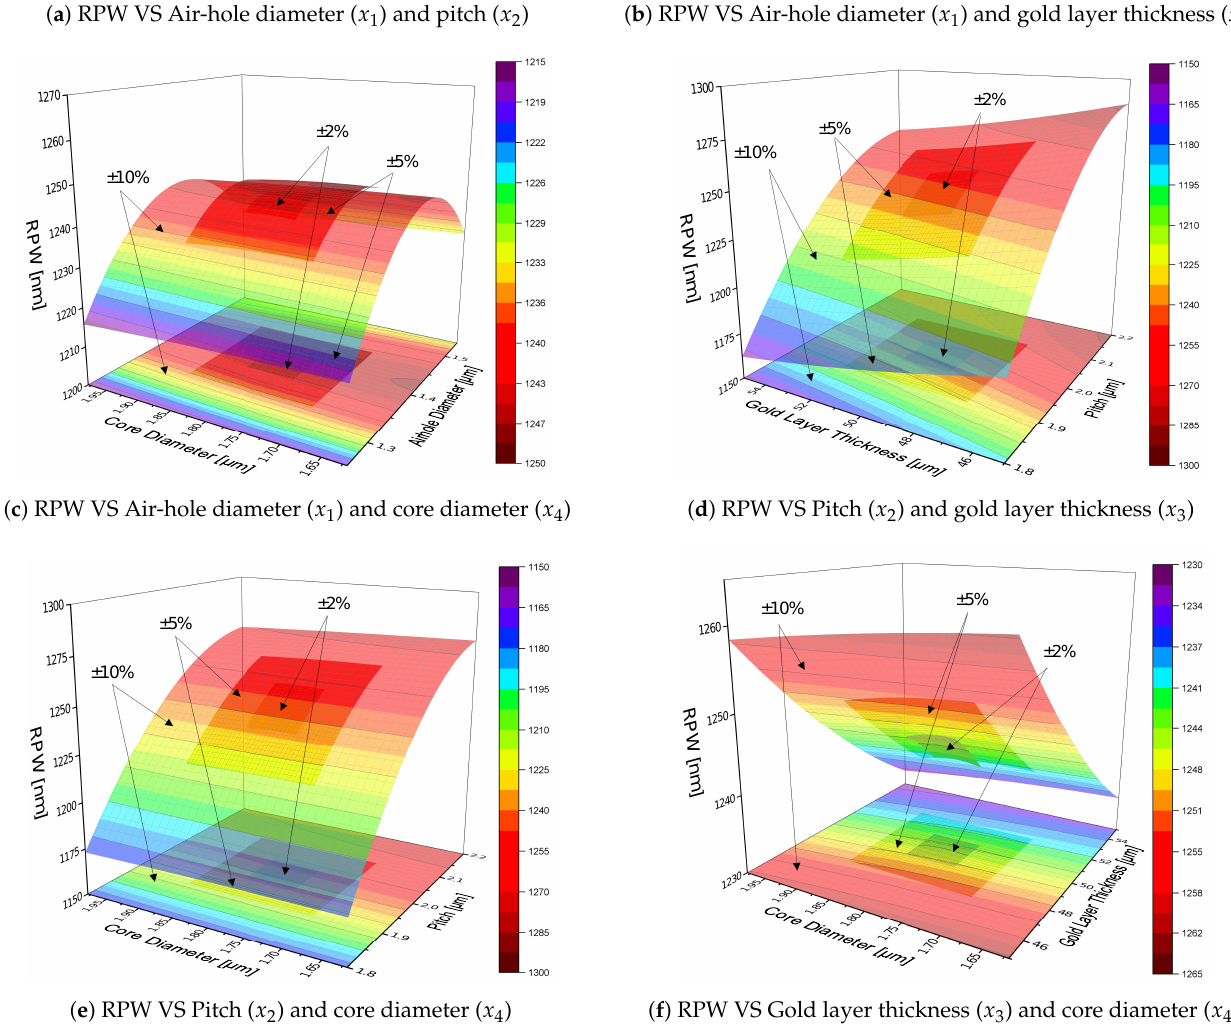
Figure 9. Response surface (3D) and contour (2D) plots of RPW with respect to the interaction of any two among the four structural parameters (air-hole diameter, pitch, gold layer thickness and core diameter) for ± 2%, ± 5% and ± 10% tolerance levels. Different levels of transparency for the surface and contour plots are set for identification as 0% (for ± 2%), 25% (for ± 5%), 50% (for ±